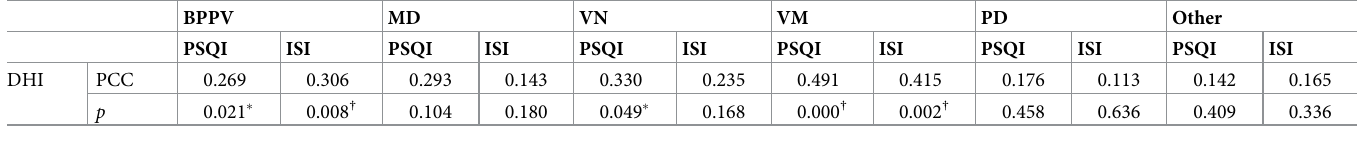
Table 3. Correlation coefficient between DHI and the tools used for measuring sleep disturbance in each group.